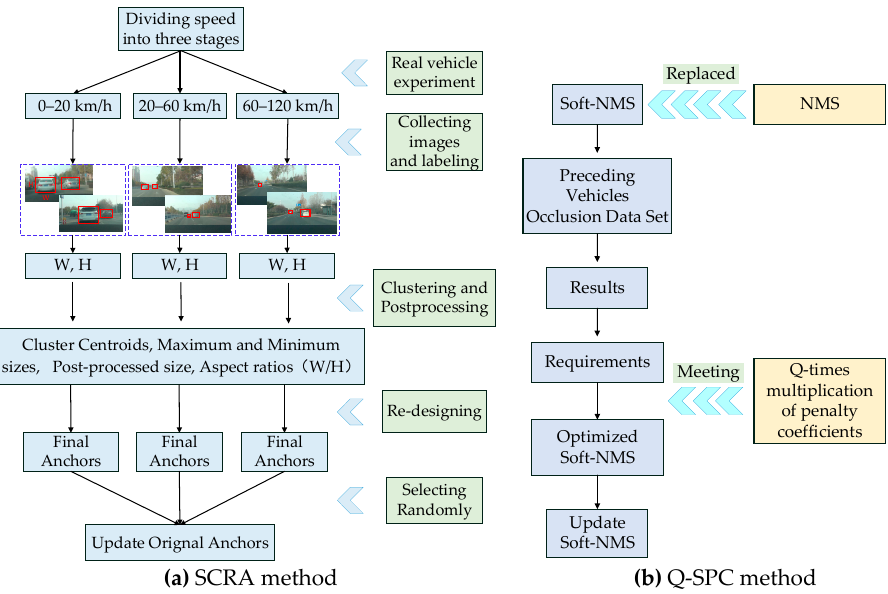
Figure 4. Working principles of ( a ) the speed classification random anchor (SCRA) and ( b ) Q-square penalty coefficient (Q-SPC) methods .